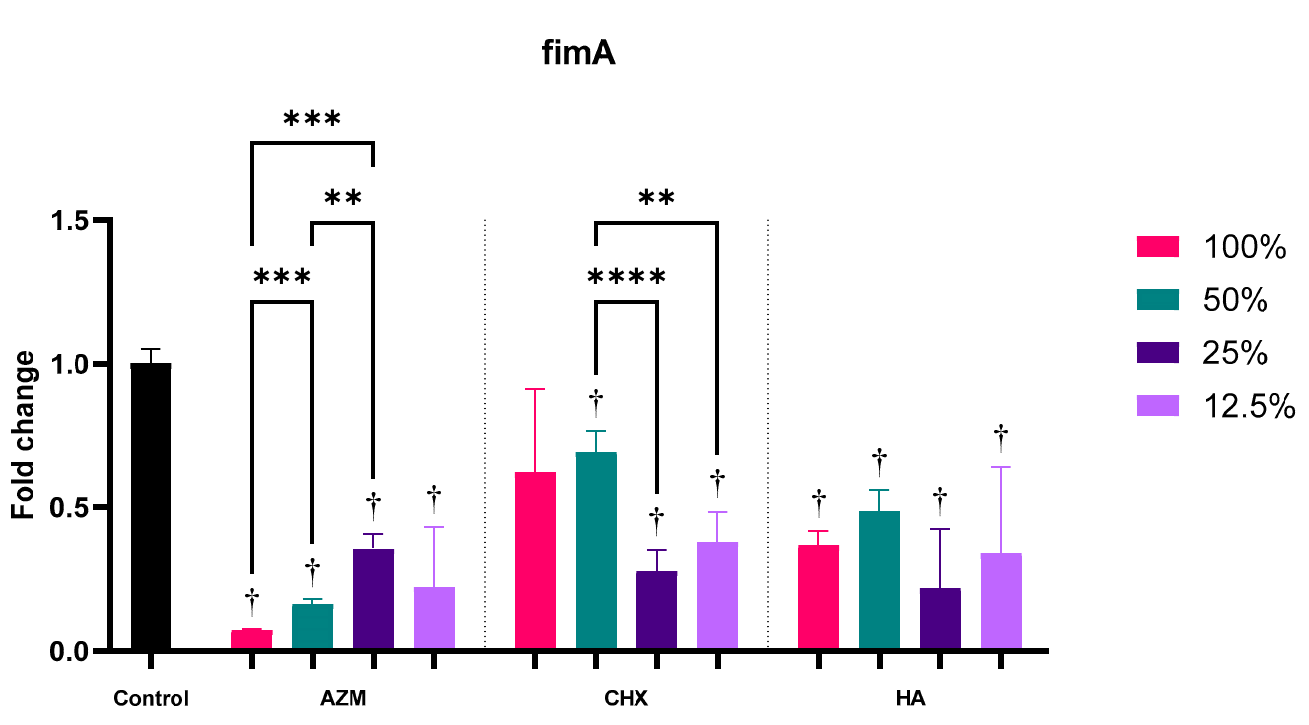
Figure 4. Fold-change values (mean ± SD) of different concentrations on expression of fimA. >0.05 (ns), ≤ 0.05 (*), ≤ 0.01 (**), ≤ 0.001 (***), ≤ 0.0001 (****). Statistically significant compared to control p < 0.05 (†).